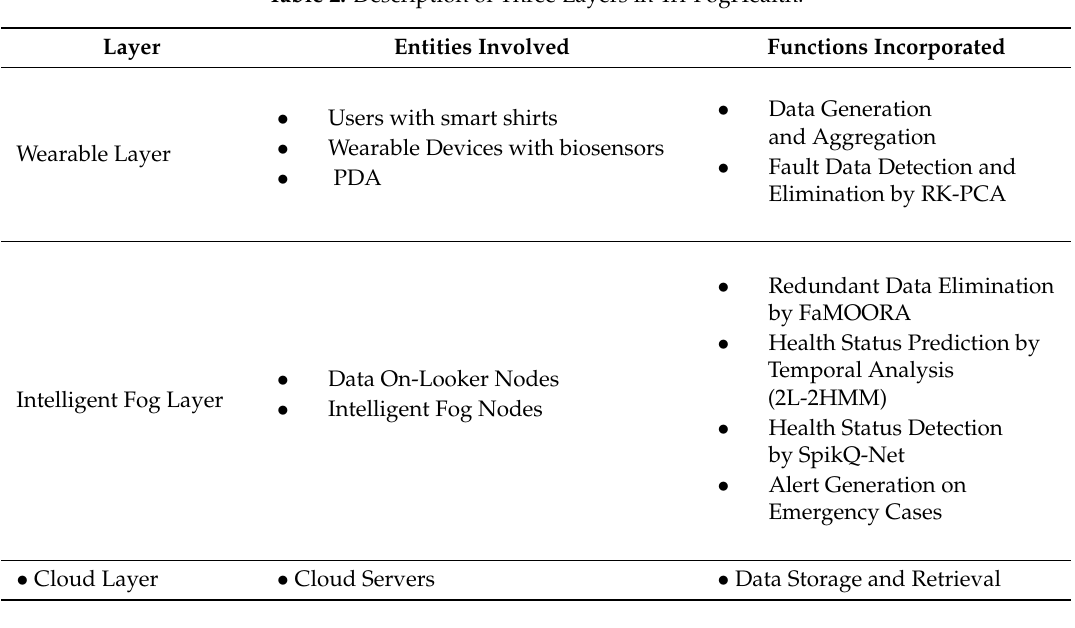
Table 2. Description of Three Layers in